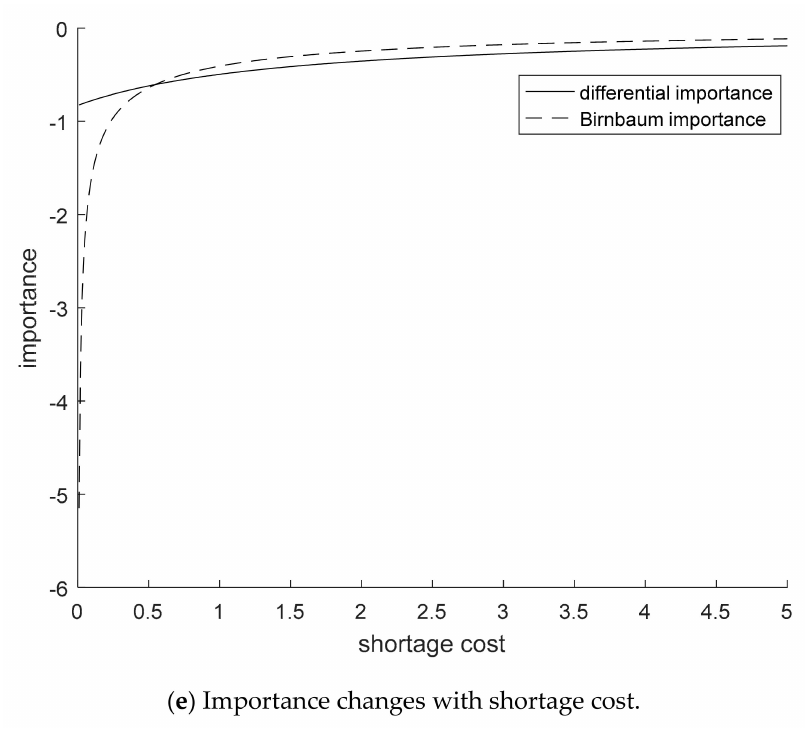
Figure 7. Importance changes with various